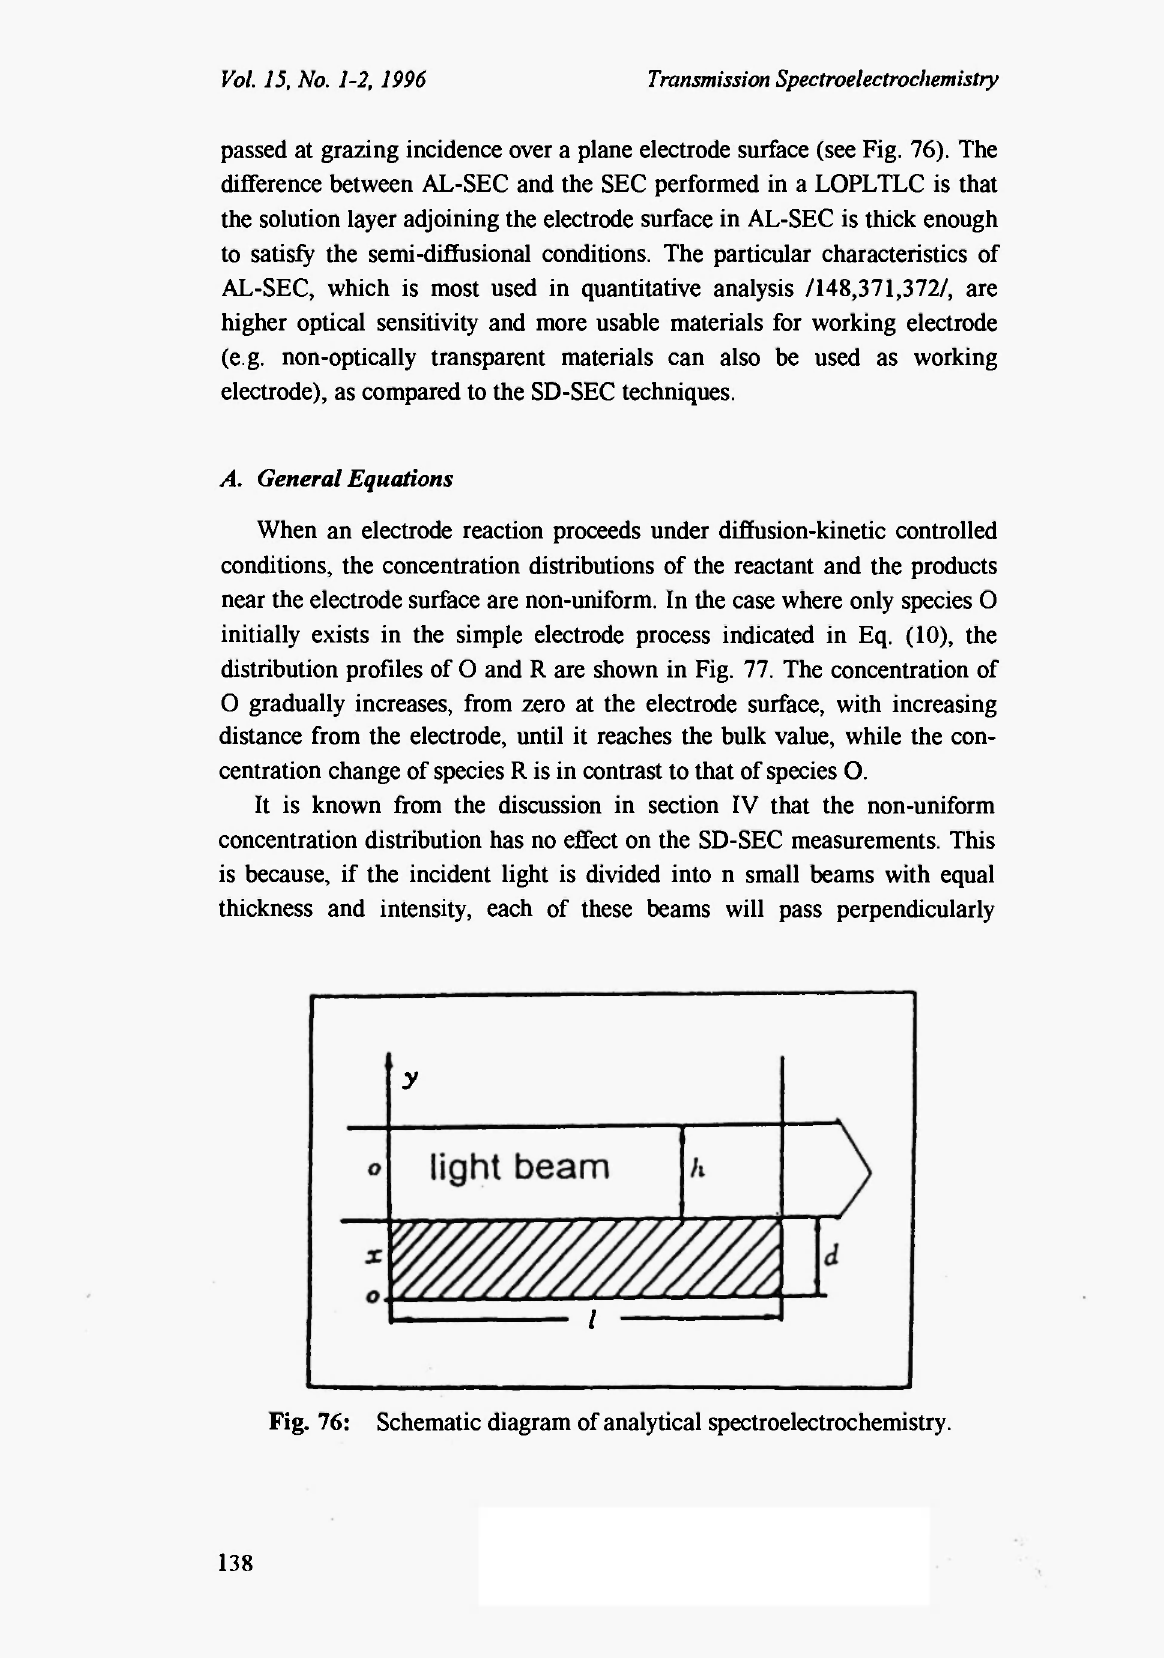
Fig. 76: Schematic diagram of analytical